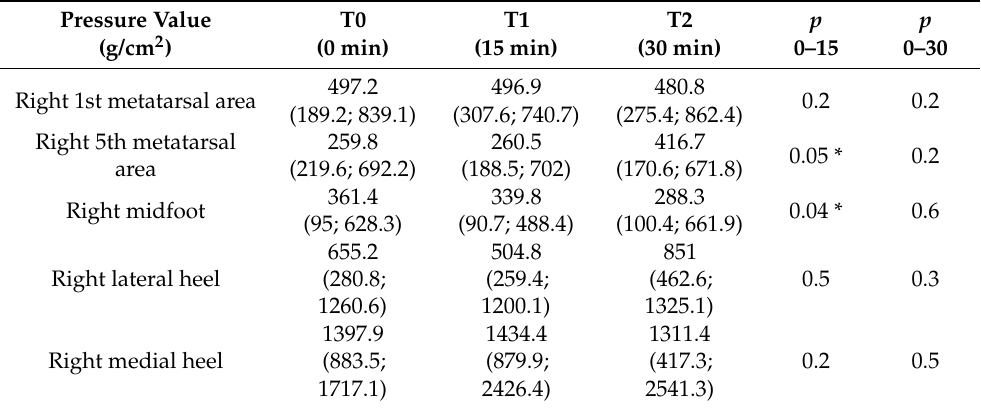
Table 1. The values of pressure recorded from the sole in the right foot (the same side as the occlusal imbalance).